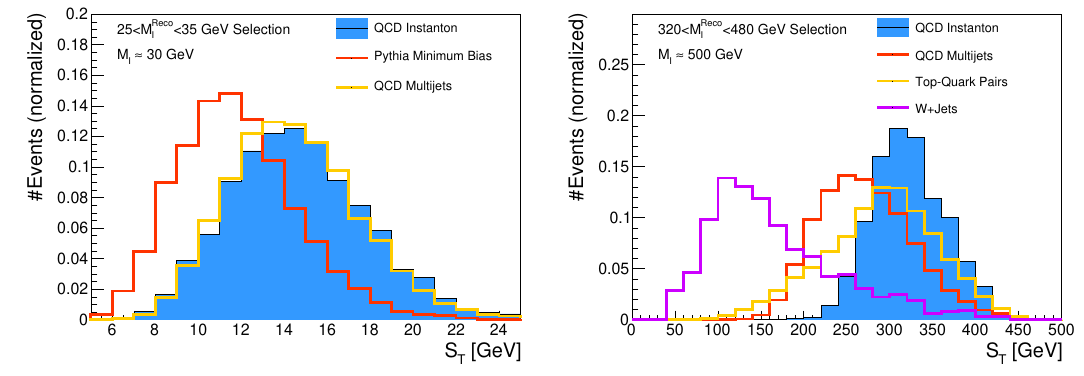
Figure 9 . Normalized S T distributions of reconstructed tracks for events with 20 < M reco 30 GeV (left) and of reconstructed particle-jets for events with 320 < M reco signal processes, the expected distributions of the background processes are shown (see table